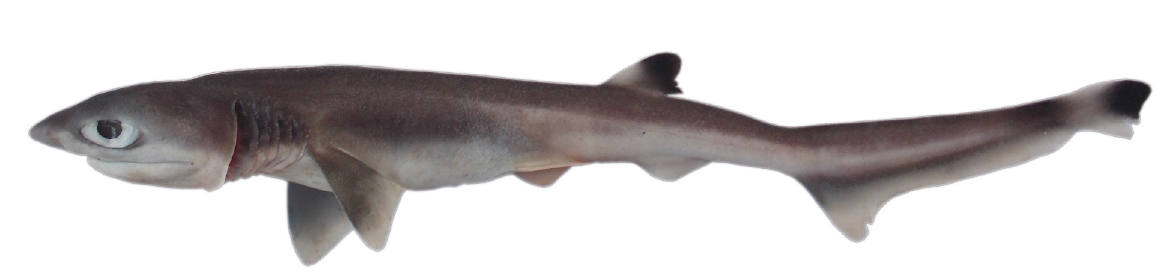
Fig. 2. Lateral view of Heptranchias perlo (PUMB 3527, 281mm TL female) from Andaman waters